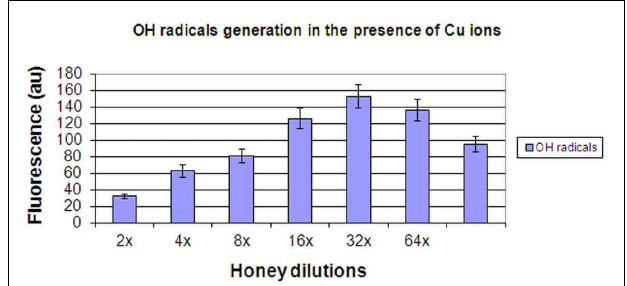
FIGURE 5 |The generation of hydroxyl radicals by honeys H77 and H76 (combined) supplemented with 400 μ M Cu(II).